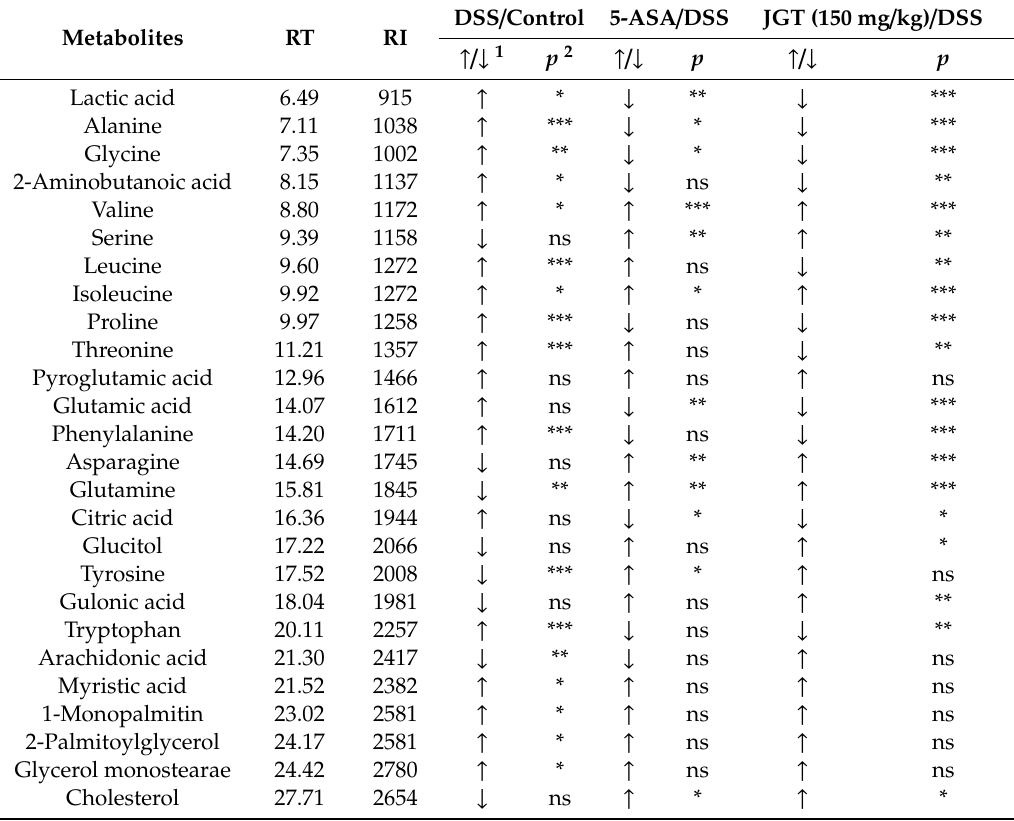
Table 1. Metabolic e ff ects in serum of DSS-induced colitis and 5-ASA or JGT administration. Metabolites